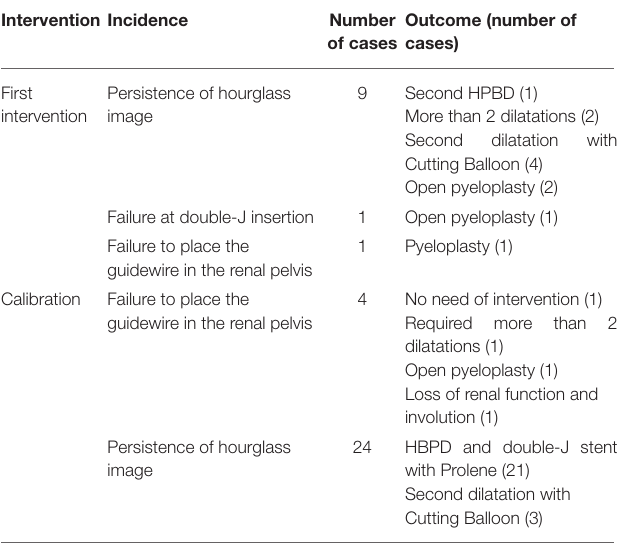
TABLE 3 | Causes of failure in the first intervention and calibration, and outcome of these patients. Intervention Incidence Number